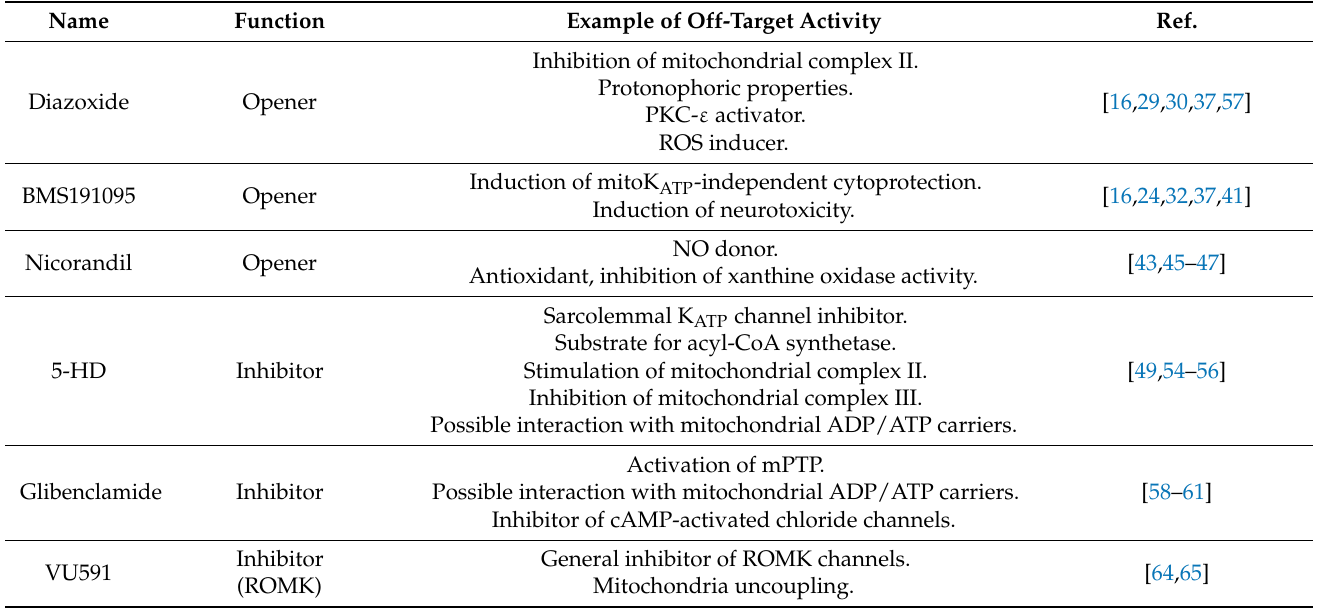
Table 1. Examples of mitoK ATP channel modulators and their off-target